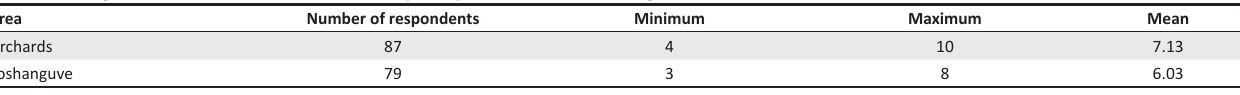
TABLE 2: Duties that domestic workers performed in Orchards ( n = 86) , Soshanguve ( n = 84) and Langenhoven Park in Bloemfontein. Duties Orchards Cleaning Washing Cooking Child- and elder-care